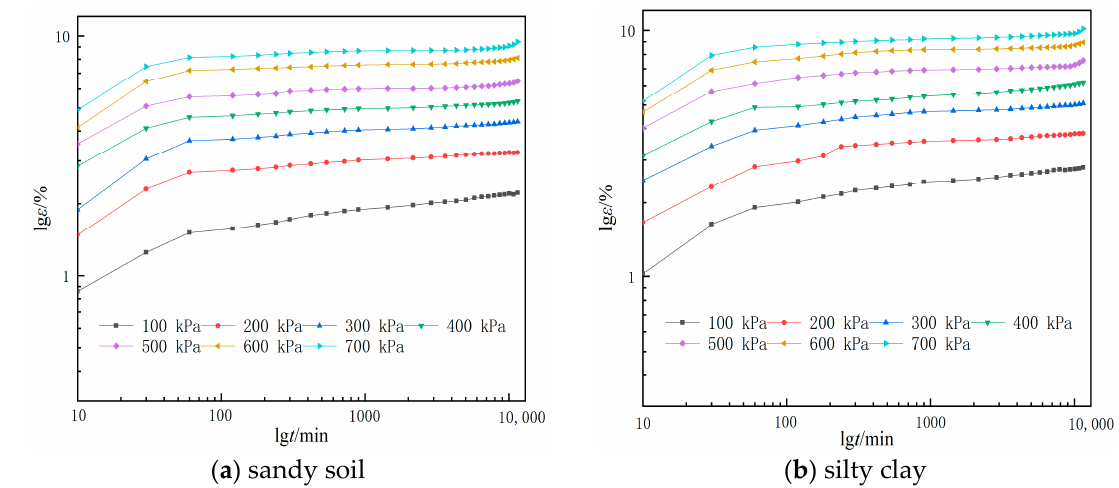
Figure 5. The strain – time curves of soil samples in logarithmic coordinates.